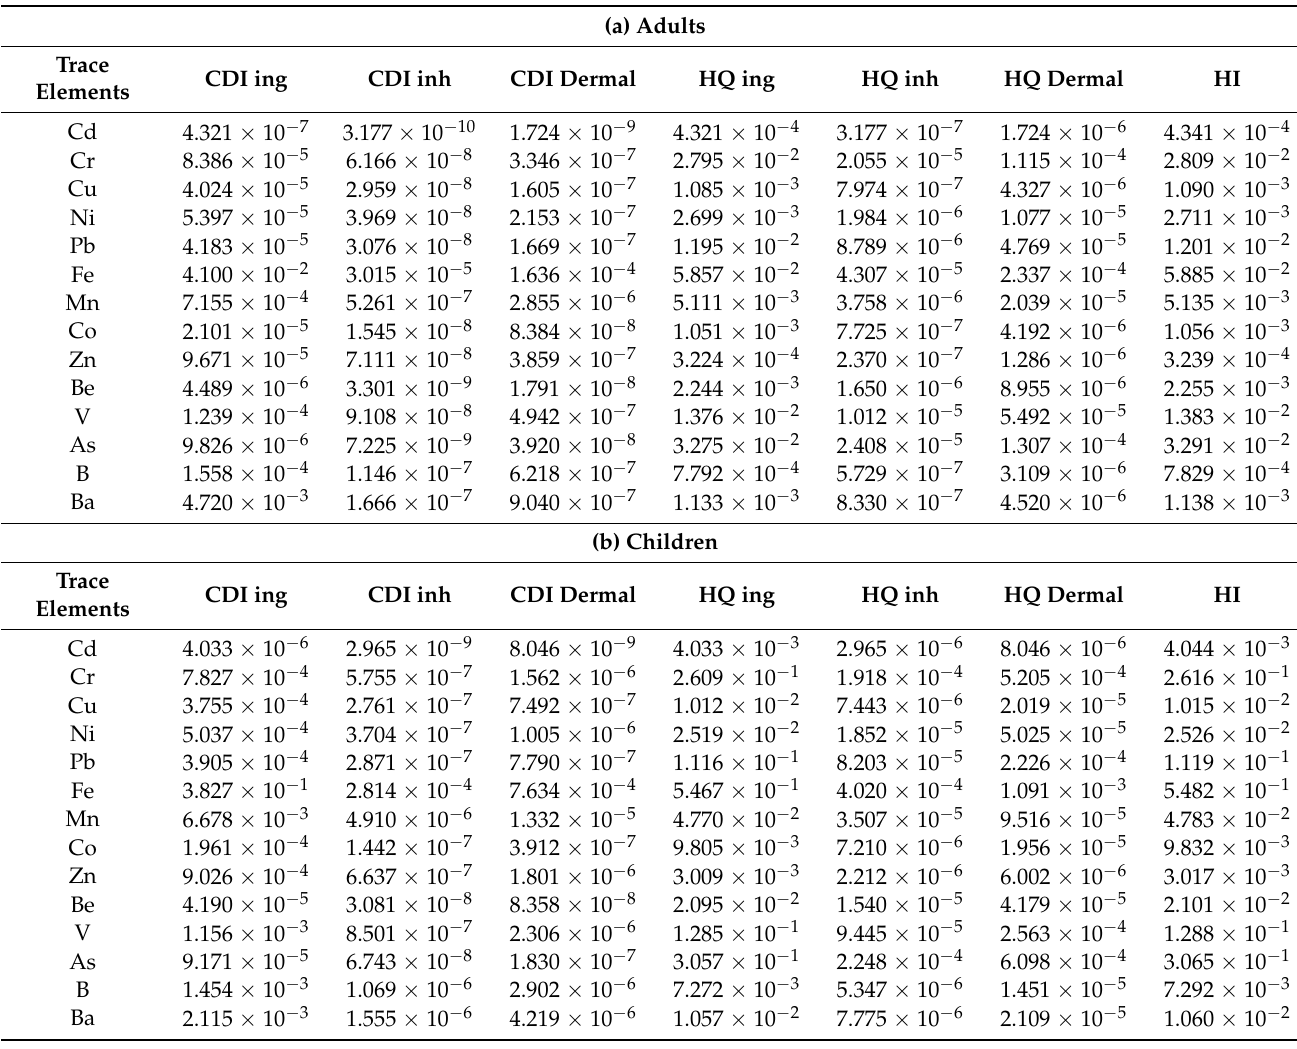
respectively. This difference suggests that children were at higher risk of non-carcinogenic exposure than adults. Table 2. Chronic daily intake (CDI) (in mg/kg · day), hazard quotient (HQ) and cumulative hazard index (HI) for non-carcinogenic risk in ( a ) adults and ( b )